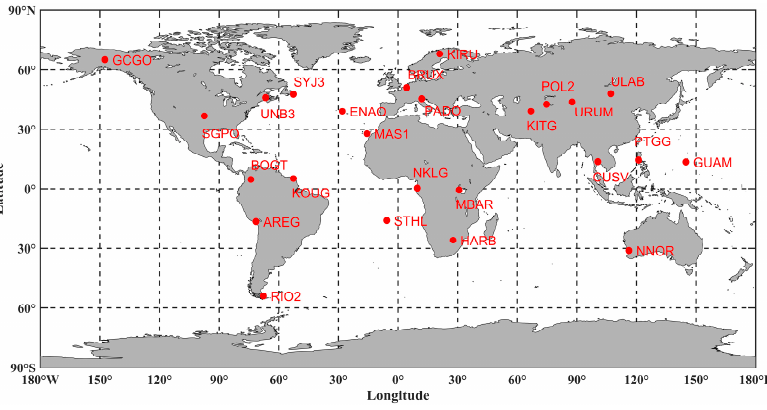
Figure 3. Distribution of 25 MGEX stations.